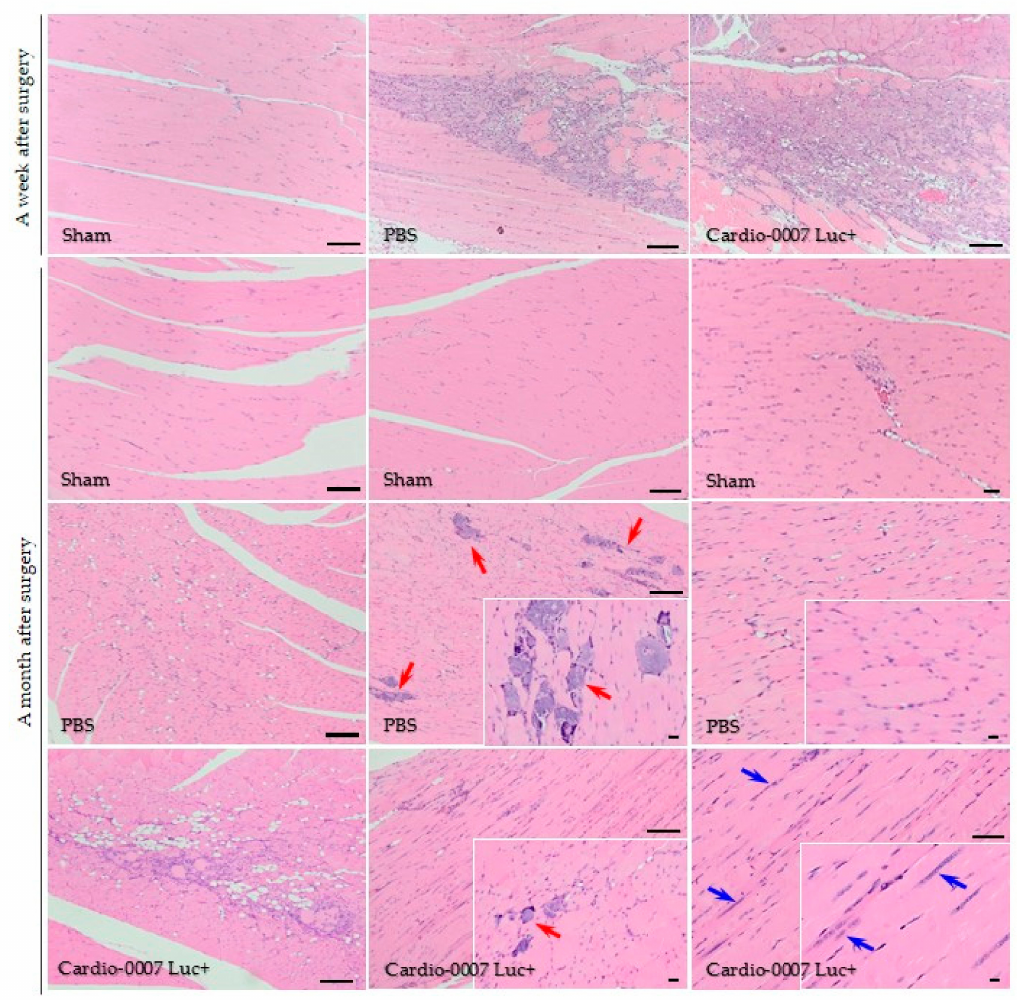
Figure 5. Histological assessment of the muscle’s structure after Cardio-0007 Luc + injection; hematoxylin / eosin staining. A month after operation in the PBS mice’s group, numerous calcifications appeared (red arrows). In the Cardio-0007 Luc + mice’s group the calcifications are rare (red arrow) and sites of tissue regeneration are visible (blue arrows); scale bar = 100 µ